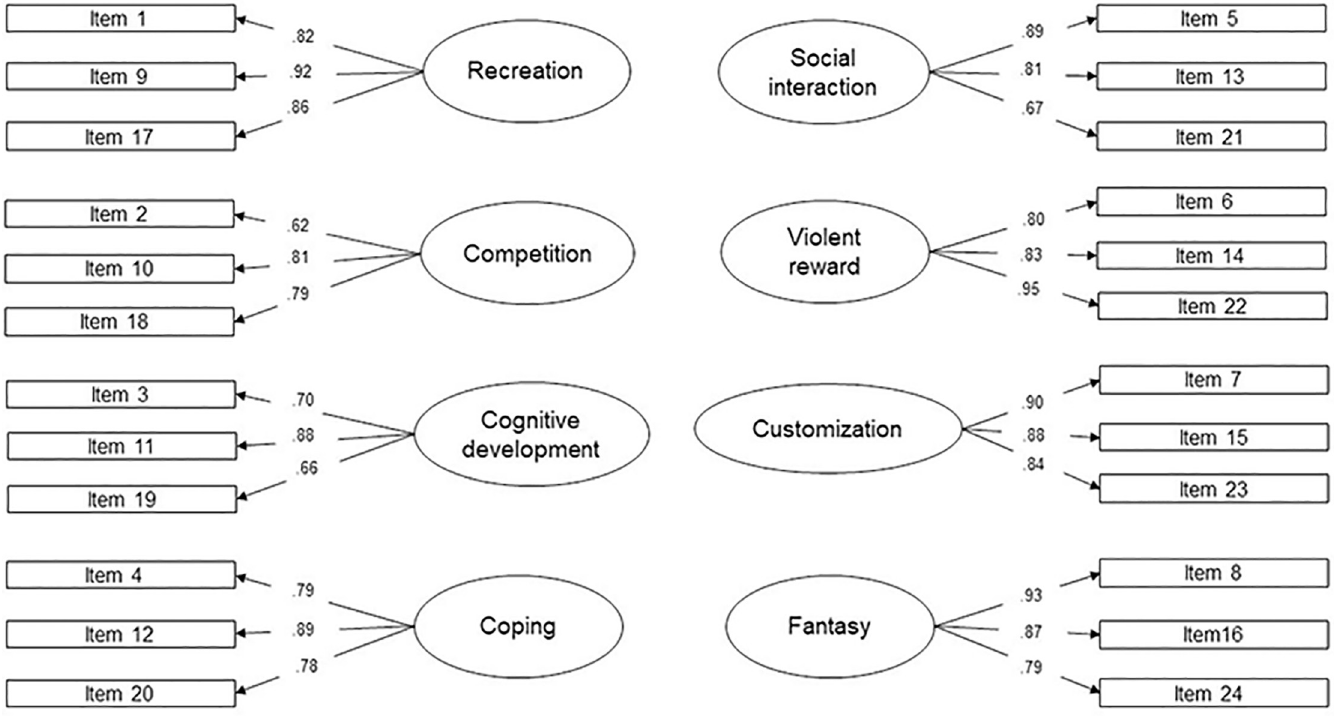
Fig 1. Confirmatory factor analysis of the VMQ among the young adult sample. For clarity, covariances between motives and errors were not depicted in the figure. All factor loadings were significant at p < .001.